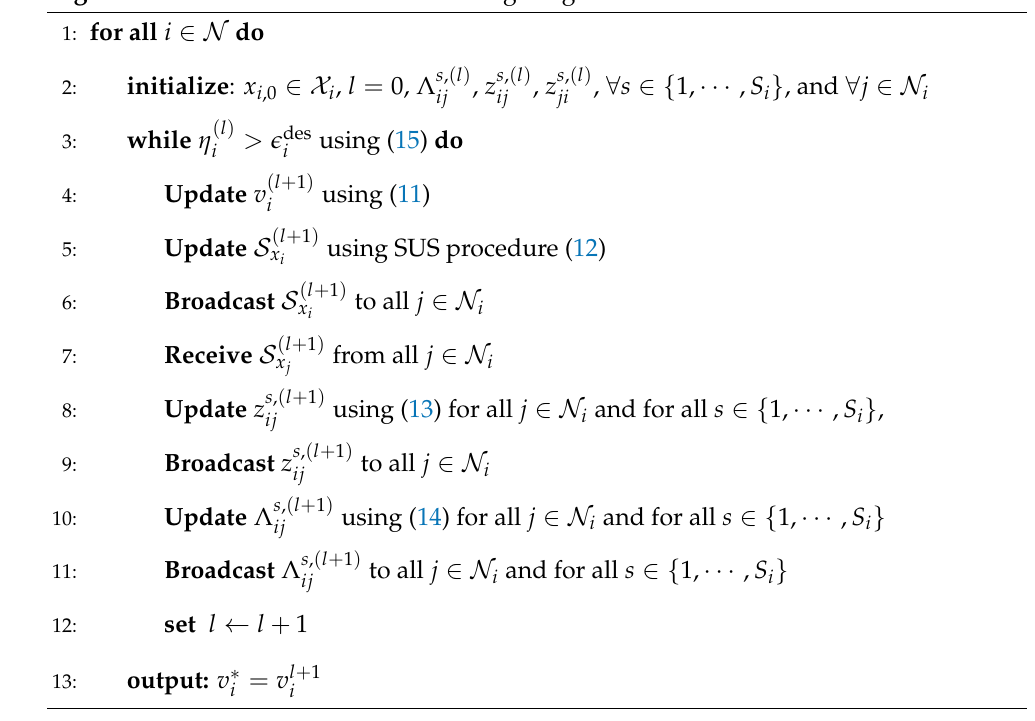
Algorithm 1 Distributed Scenario Exchange